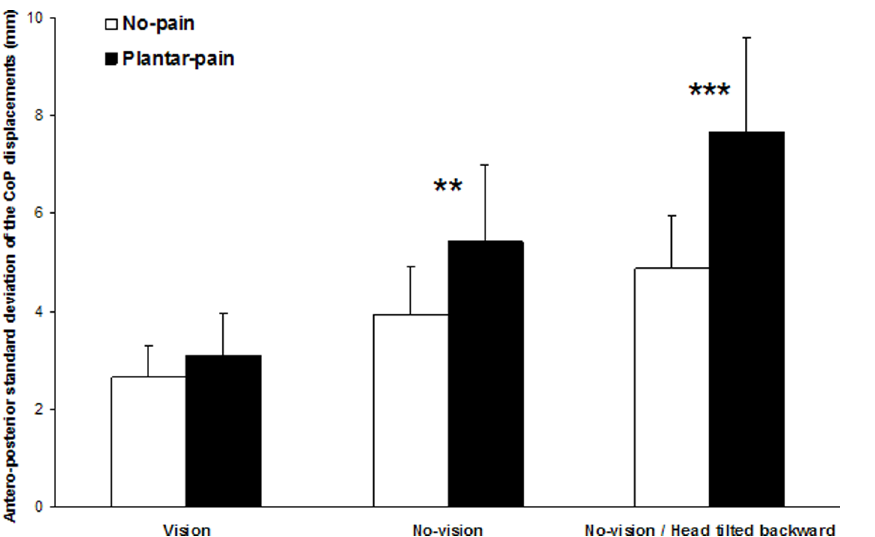
Figure 3. Mean and standard deviation of the standard deviation of the CoP displacements along the antero-posterior axis for the three sensory conditions and the two pain conditions. The No-pain condition is represented by white bars and the Plantar-pain condition by black bars . The significant P values for comparison between No-pain and Plantar-pain conditions are reported (**: P , 0.01; ***: P , 0.001).